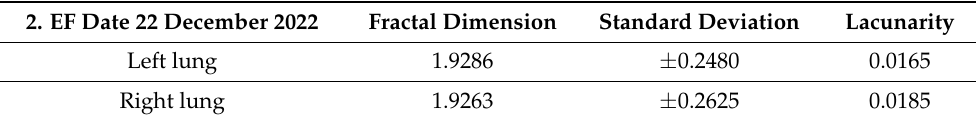
Figure 10. De fi ning the mask for the right lung of the second patient. Table 2. Fractal indicators for the second patient.